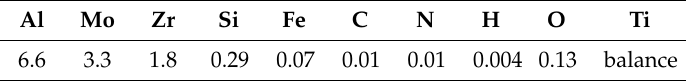
Table 1. Chemical composition (wt. %) of TC11